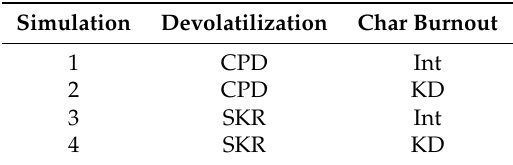
Table 9. Details of the models included in the present test cases. Int: Intrinsic; KD: Kinetic/Diffusion; SKR: Single Kinetic